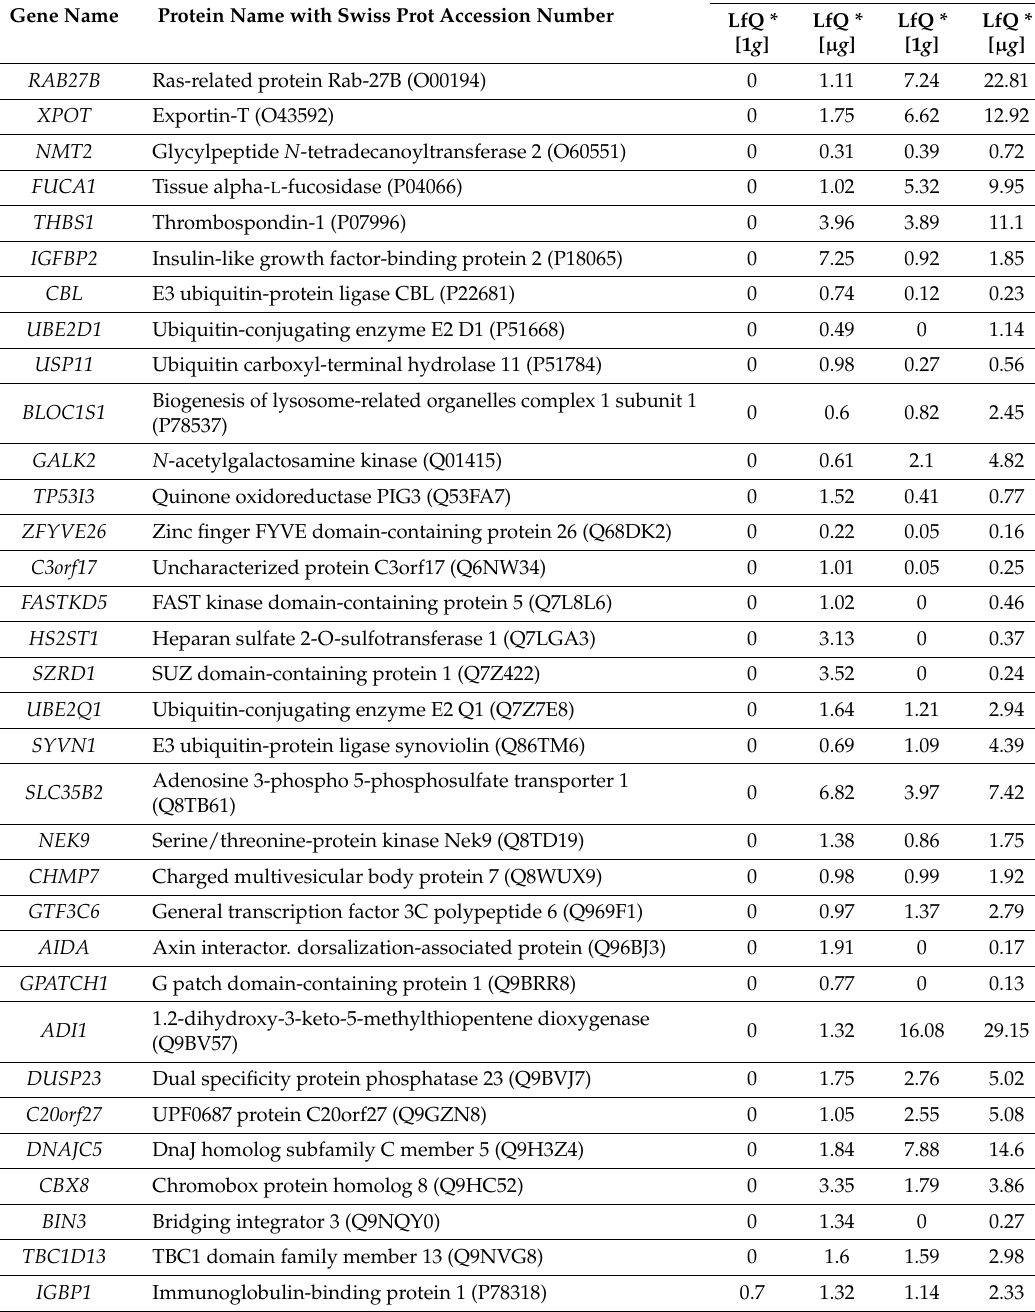
Table 1. List of 69 selected proteins that were imported into the Knowledge Explorer, with protein names, gene names, accession numbers and LfQs * obtained for proteins of FTC-133 cells, before it was used for searching UniProt. LfQ * values for MCF-7 cells are given for